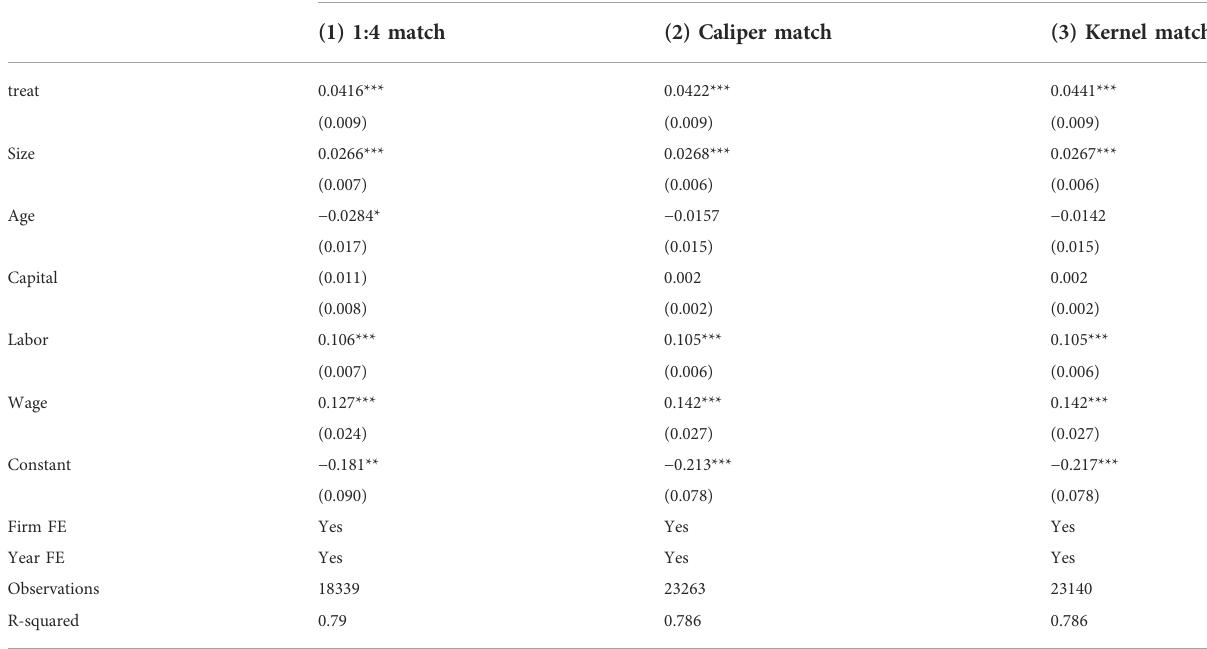
TABLE 3 The result of other matching